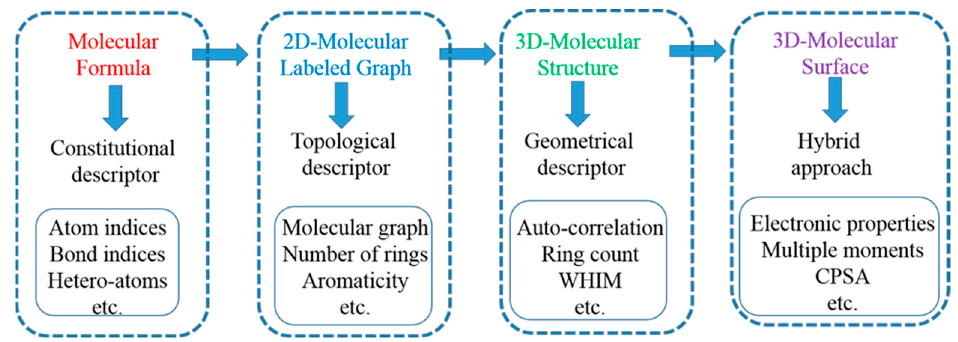
Figure 2. Hierarchical developmental tree of QSAR descriptors for applications in molecular design.